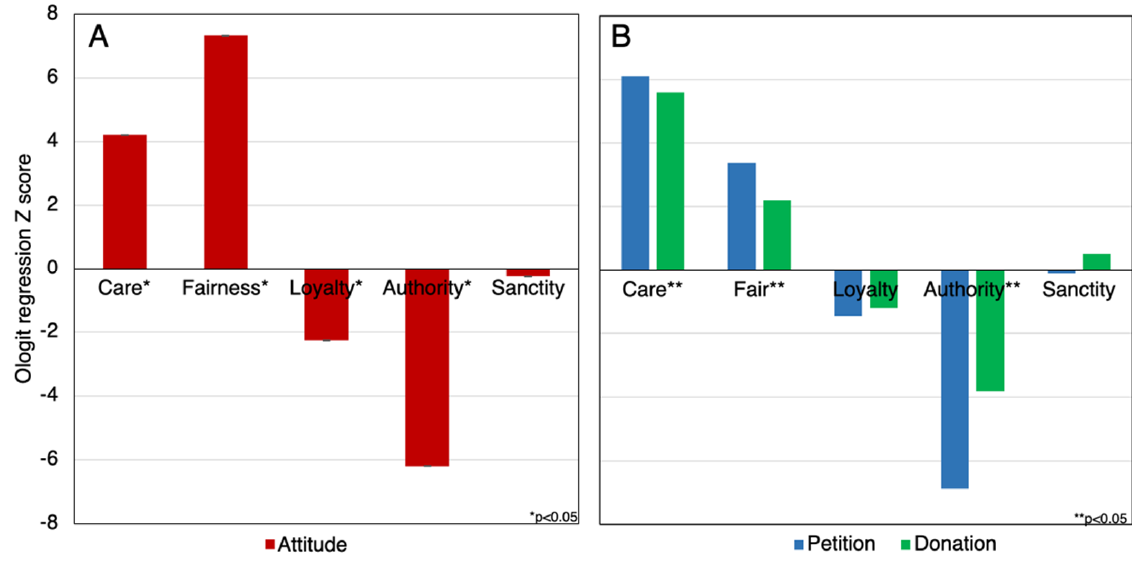
( B ) pro-refugee Figure 4. Displaying moral foundation scores by ( A ) the average attitude toward refugees and ( B ) pro-refugee behaviour.